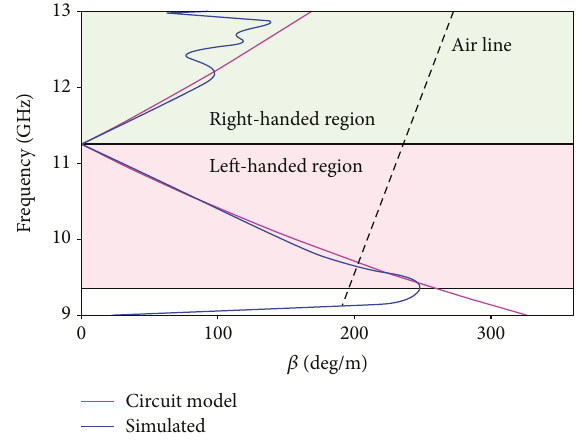
Figure 3: Comparison of the dispersion characteristics of the designed CSIW-CRLH obtained by full-wave simulation and equivalent circuit prediction. L C